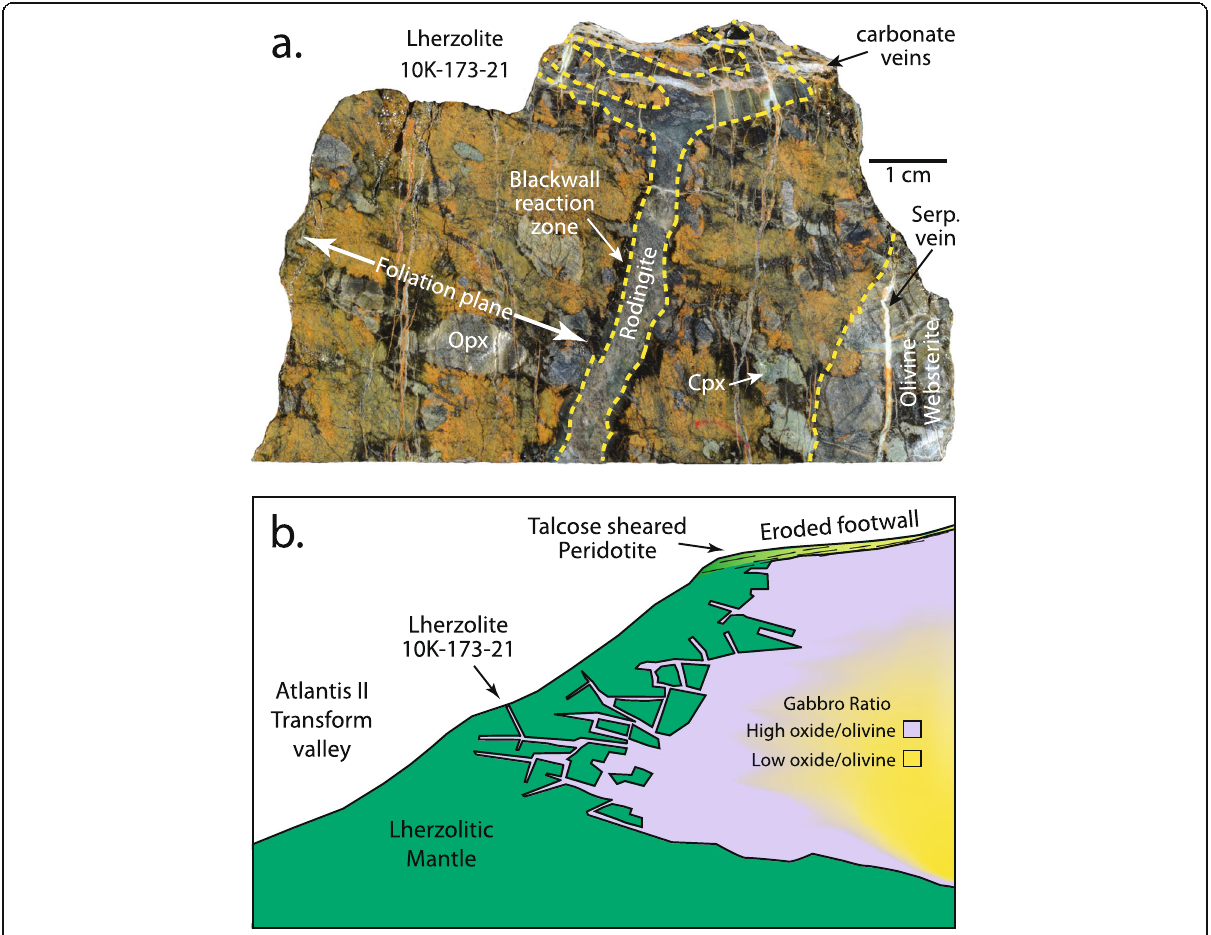
Fig. 43 a ROV Kaiko Dive 173 sample 21 (Fig. 42): Spinel lherzolite and a crosscutting a metasomatized gabbro vein (rodingite) with a black-wall metasomatic reaction zone in the peridotite along the contact. The branching vein is part of a gabbro net vein complex in the peridotite, which is usually the indicator of a nearby intrusive body. On the right side is a selvage of olivine websterite consisting of enstatite, diopside, and olivine in sutured contact with the peridotite. b Cartoon showing possible configuration of the gabbro-mantle contact and, more speculatively, where it turns into the crust-mantle boundary beneath Atlantis Bank. The “ Gabbro Ratio ” reflects the transition from dominantly olivine gabbro intercalated with subordinate oxide gabbro to dominantly oxide gabbro intercalated with subordinate olivine gabbro as the mantle contact is